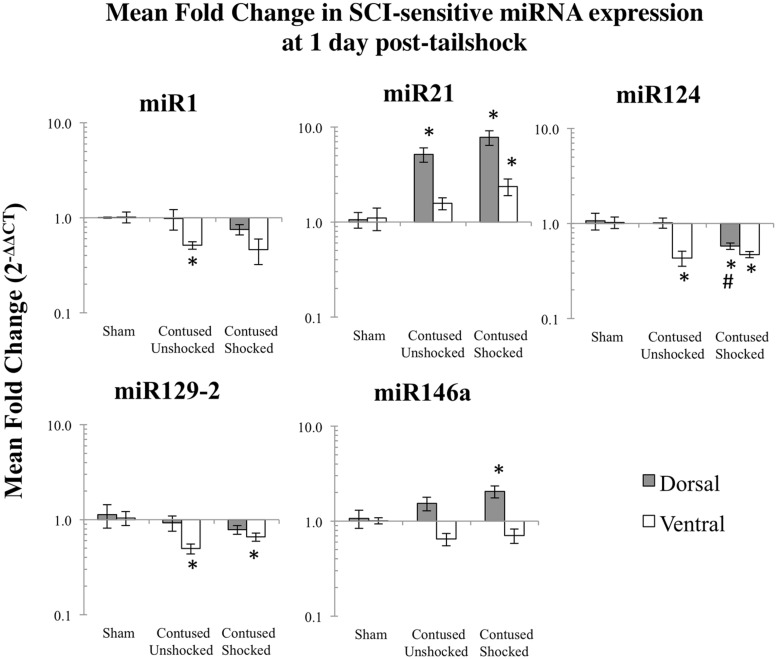
Bar graphs depicting qRT-PCR analysis of miRNA expression of miR1, miR21, miR124, miR129-2, and miR146a at the lesion site for sham animals and after unshocked or shock treatment in contused animals at 1 day following tailshock treatment. The x-axis denotes treatment condition, and the y-axis denotes the log of mean fold expression change of miRNA. Data are normalized relative to U6 small nuclear RNA internal gene expression and expressed as the mean of all fold changes of individual samples within a treatment group relative to the mean of the treatment group (+SEM), with asterisks indicating significance (LSD) compared with sham controls and hash tags indicating significance (LSD) compared with contused unshocked controls; p values are as indicated in the text.